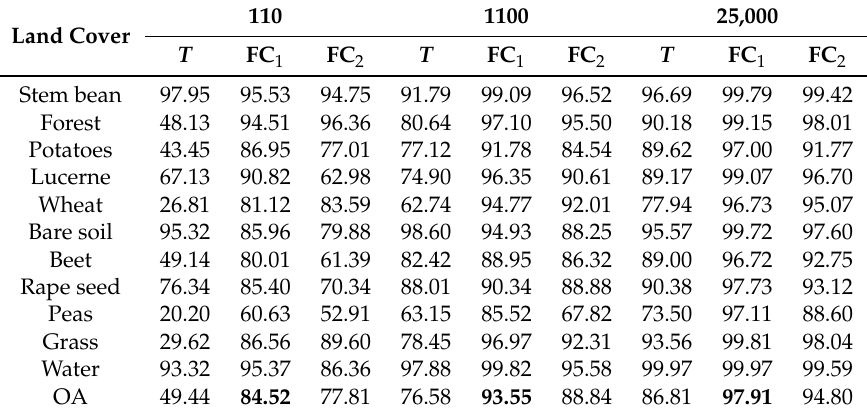
Table 8. The semi-supervised classification accuracies of AIRSAR Flevoland (%). Land